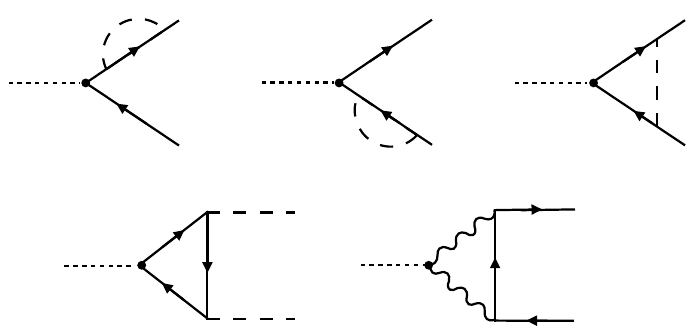
Figure 3 . One-loop diagrams accounting for operator mixing through Yukawa interactions and gauge